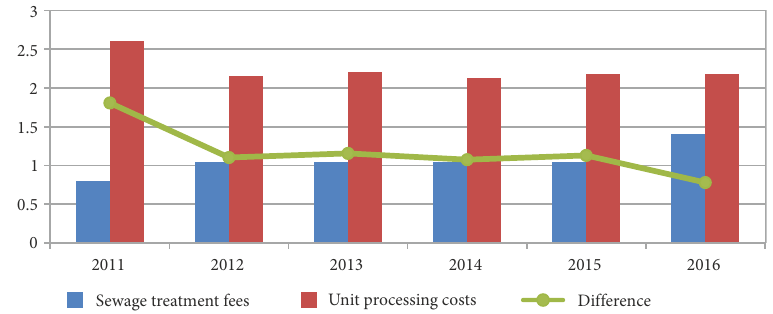
Figure 12. Sewage treatment fees and unit processing